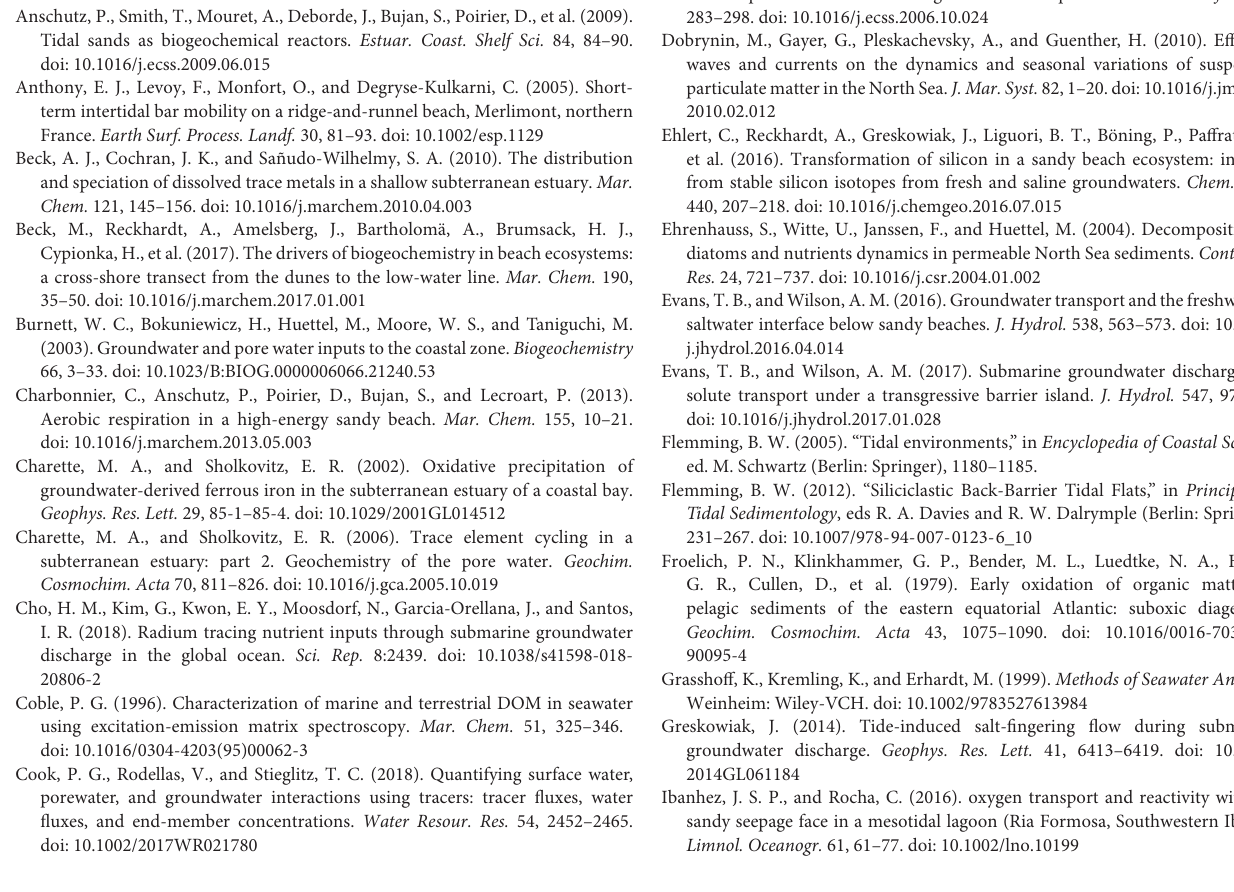
FIGURE S1 | Beach topography and physico-chemical parameters (for sampling depth 100 cm) of Spiekeroog beach for the three sampling campaigns. FIGURE S2 | Biogeochemical parameters (for sampling depth 100 cm) of Spiekeroog beach for the three sampling campaigns. FIGURE S3 | Correlation plots (Spearman‘s rank test) of physico-chemical parameters between sampling depths 50 and 100 cm for Spiekeroog beach for the three sampling campaigns. Ellipse directions and colors depict type of correlation (positive or negative). Ellipse shapes depict strength of the correlation. Stars denote the p -value ( ∗ = 0.05, ∗∗ = 0.01, ∗∗∗ = 0.001 significance level), numbers denote the correlation coefficient (Spearman‘s ρ ). FIGURE S4 | Flux calculations for Fe(II) and FDOM using pore water data from 50 cm depth. Left panel: definition of infiltration and exfiltration zones for the three campaigns. HWL, high water line (infiltration zone); Runnel Ex1, upper part of runnel (exfiltration zone, 3.15 m 3 d − 1 m − 1 shoreline); Runnel Ex 2, lower part of runnel (exfiltration zone, 0.85 m 3 d − 1 m − 1 shoreline), Ridge (infiltration zone); LWL Ex3, Low water line (exfiltration zone, 1 m 3 d − 1 m − 1 shoreline). For the random approach, points were selected without regards to zonation, and multiplied with